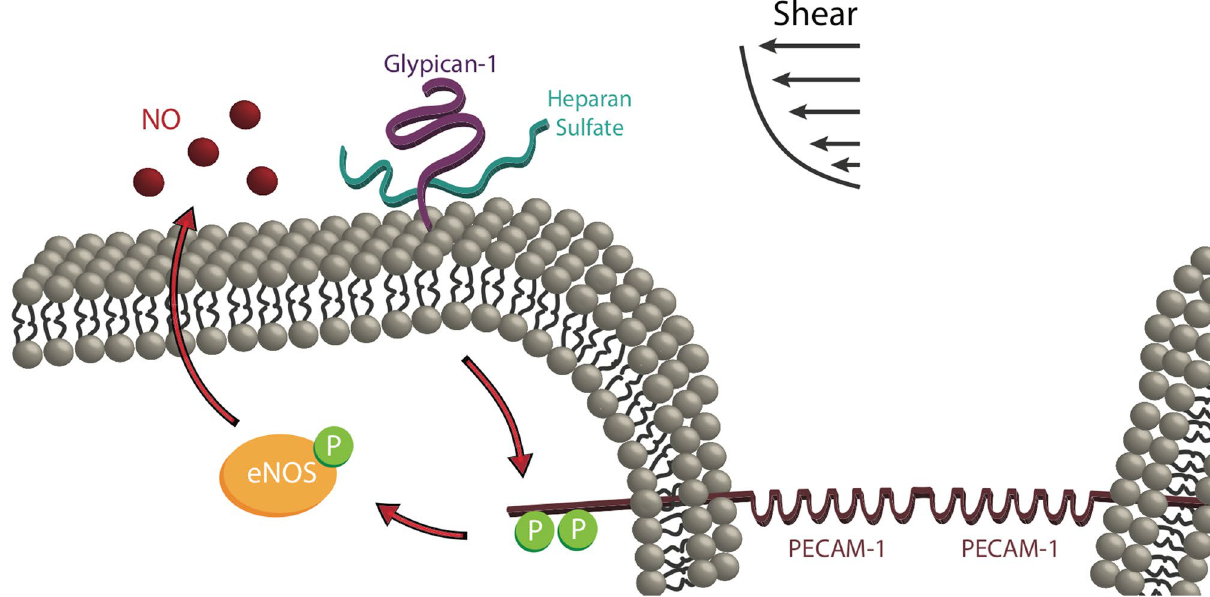
Figure 7. Shear-induced NO production via heparan sulfate and glypican-1 mechanotransduction and PECAM-1 phosphorylation leading to eNOS activation and NO synthesis. Fluid shear stress is initially sensed by heparan sulfate proteoglycan glypican-1. That signal is transduced to the intracellular tail of PECAM-1 protein. PECAM-1 becomes activated by tyrosine phosphorylation. PECAM-1 activation triggers phosphorylation of eNOS and NO production increases. NO diffuses out of the cell through the membrane to engage in autocrine or paracrine